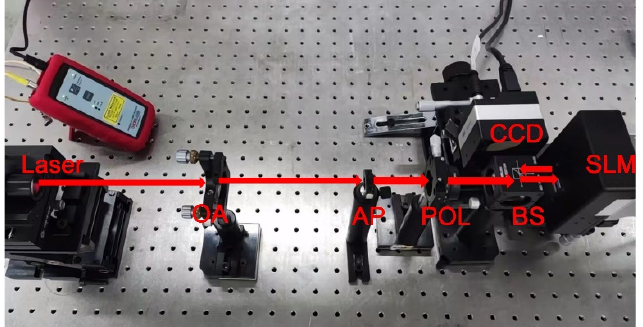
Figure 10. Statistical results of RMS values of residual wavefront with different subaperture numbers.